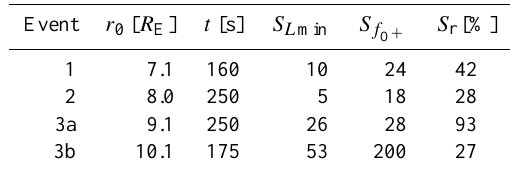
Table 2. Calculated parameter values from the backward simula- tion. r 0 is the geocentric altitude at which the heating starts, t is the heating time, S L min and S f (given in (mVm − 1 ) 2 Hz − 1 ) are O + the input value of the power spectral density due to left-hand po- larized electric fields needed to obtain the observed perpendicular temperatures and the observed power spectral density respectively. The ratio S r = S L min /S f show how much of the observed power O + spectral density that needs to be due to left-hand polarized electric waves, in order to obtain the observed perpendicular